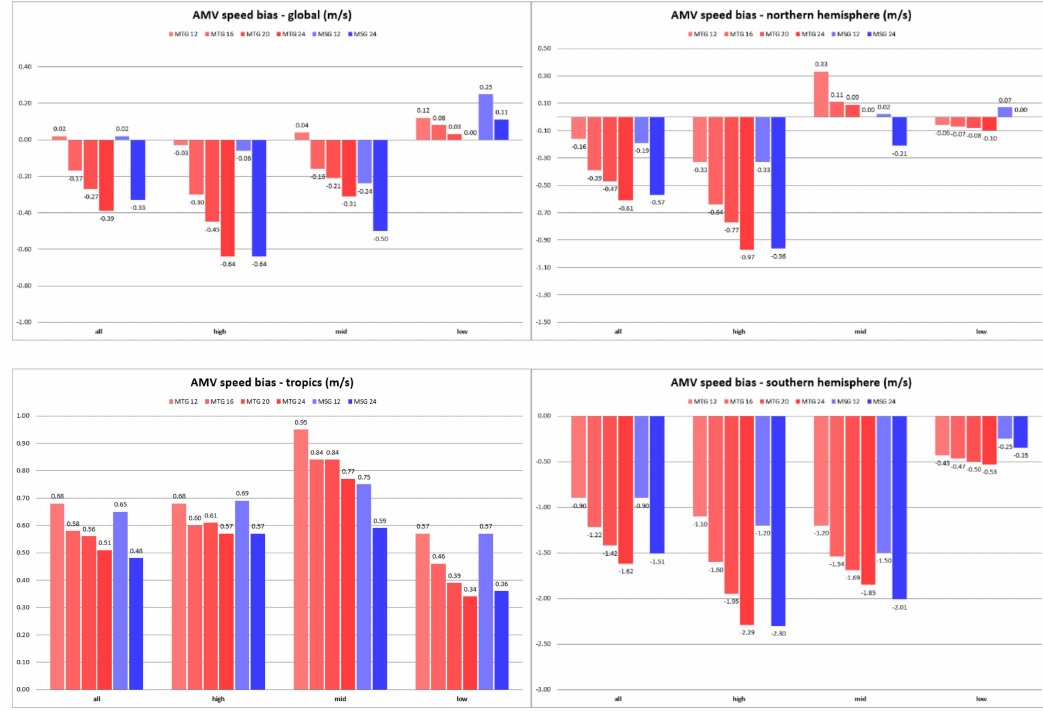
Figure 7. Channel IR10.8 AMV speed bias against forecast for the MSG / SEVIRI (blue) and MTG / FCI (red) algorithms, global (top left,) northern hemisphere (top right), tropics (bottom left) and southern hemisphere (bottom right), from 14 May to 14 June 2016 (QI >